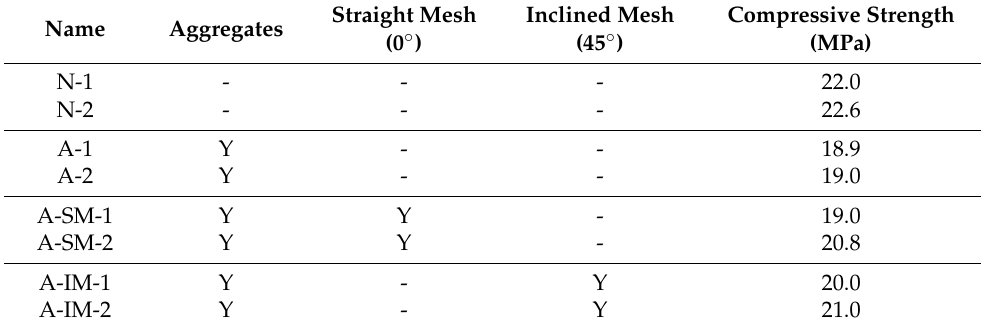
Table 1. Specimen labelling and concrete